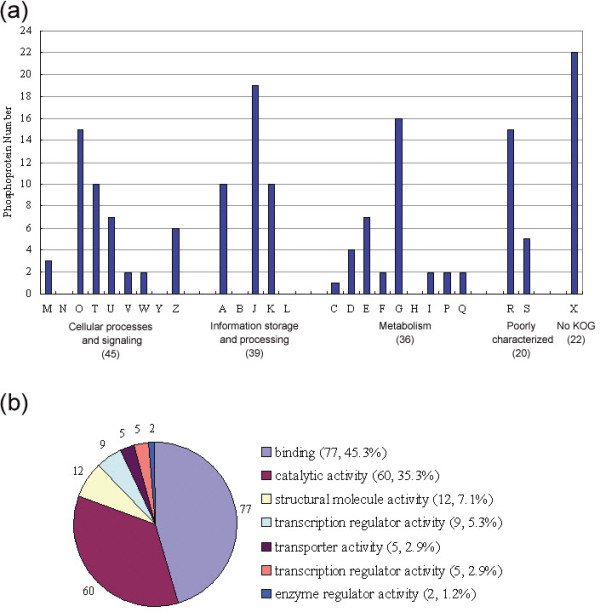
KOG and molecular functional classification of phosphoproteins identified from poplar DTBs with verified phosphopeptides (n = 151). (a) KOG classification of phosphoproteins identified from poplar DTBs; X represents phosphoproteins without KOG classification; (b) Molecular functional classification of identified phosphoproteins.